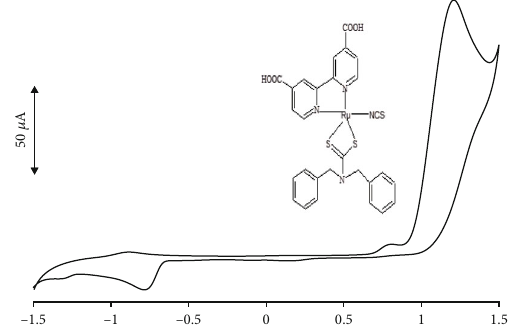
Figure 6: Cyclic voltammogram of FC